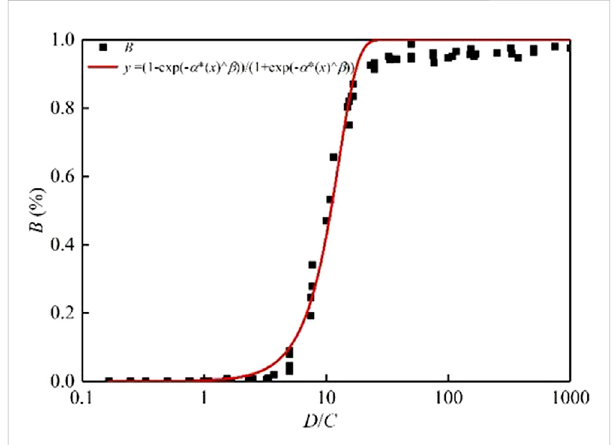
Thefunctionbetweenblockiness,fracturediameter,andfracture